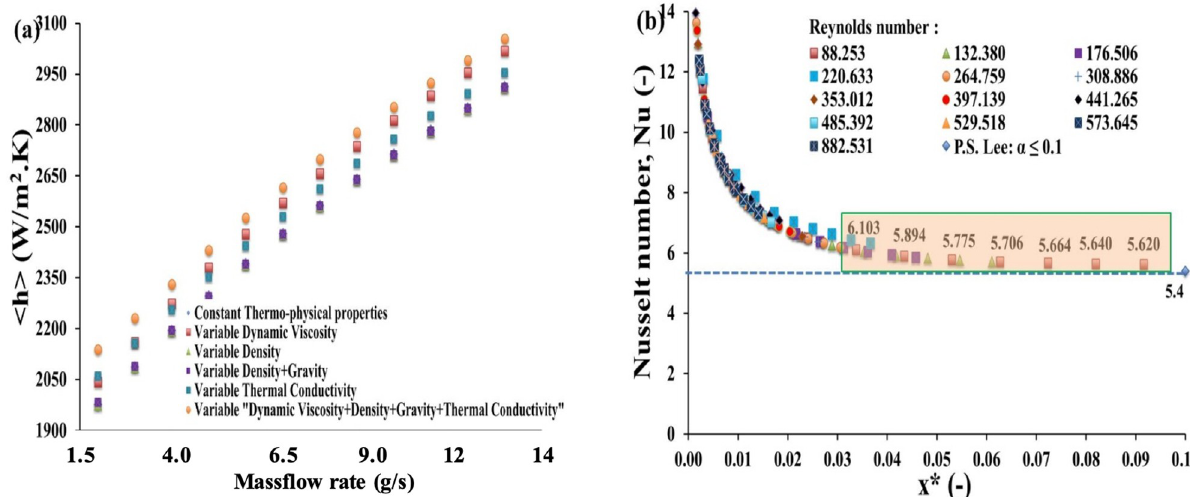
Fig 2. Impact of thermo-dependent fluid properties and comparison with analytical results. a) Global heat transfer coefficient ( < h > ) obtained using constant and variable thermo-physical properties as a function of the mass flow rate. (b) Evolution and validation of Nusselt number along x � for different Reynolds numbers in a rectangular channel heated by a constant heat flux on one side. Analytical results from Lee et al. [17] are obtained for an aspect ratio α � 0.1.